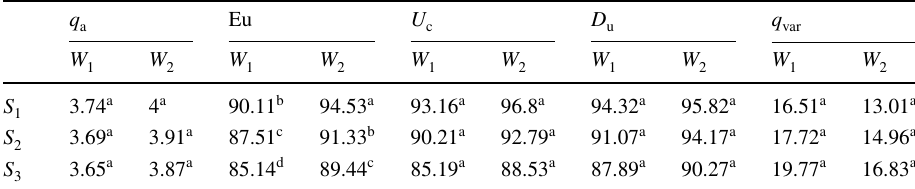
Each value in the table is an average of three